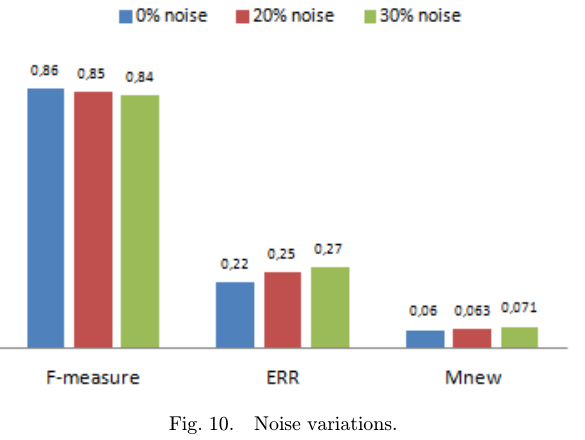
Fig. 10. Noise variations.